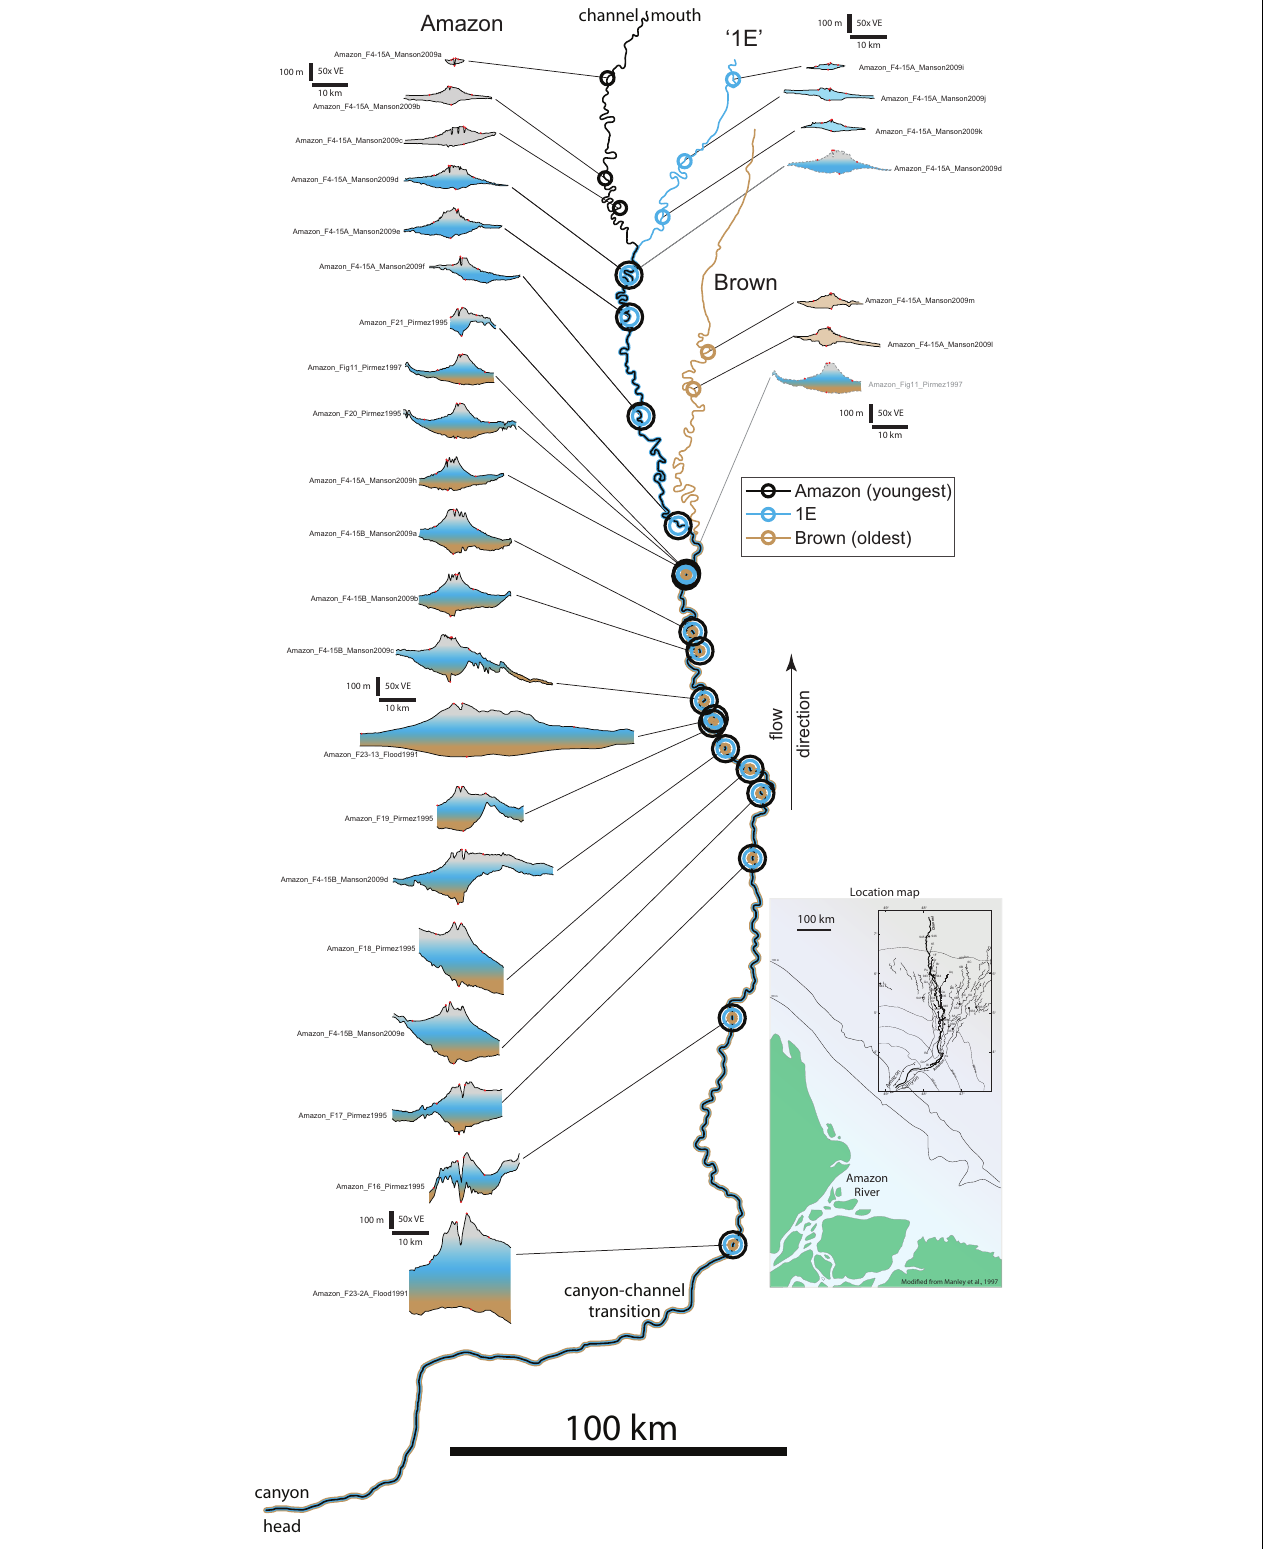
Frontiers in Earth Science |